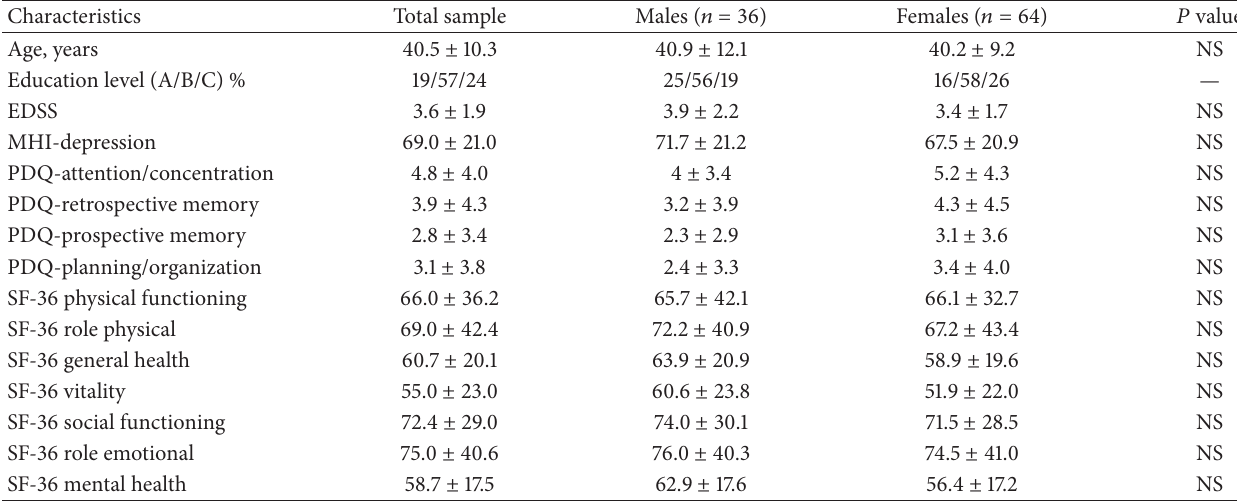
Table 1: Characteristics of MS patients ( 𝑛 = 100 ).